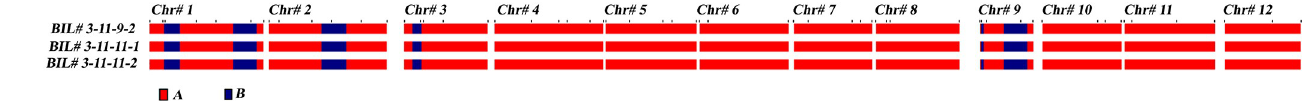
PLOS ONE | https://doi.org/10.1371/journal.pone.0227421 January 7,